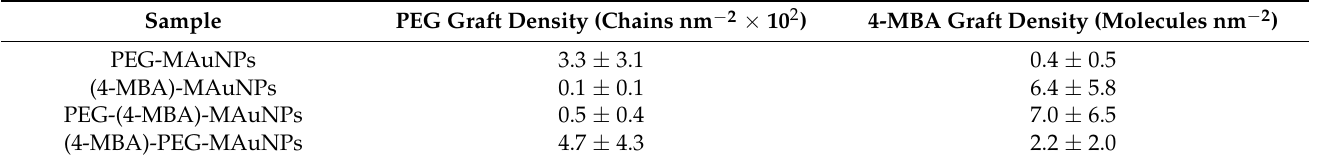
Table 2. PEG and 4-MBA graft densities, as calculated by Equation (2). Error values shown were calculated using the standard deviation of the NMR data and the TEM D MAuNP